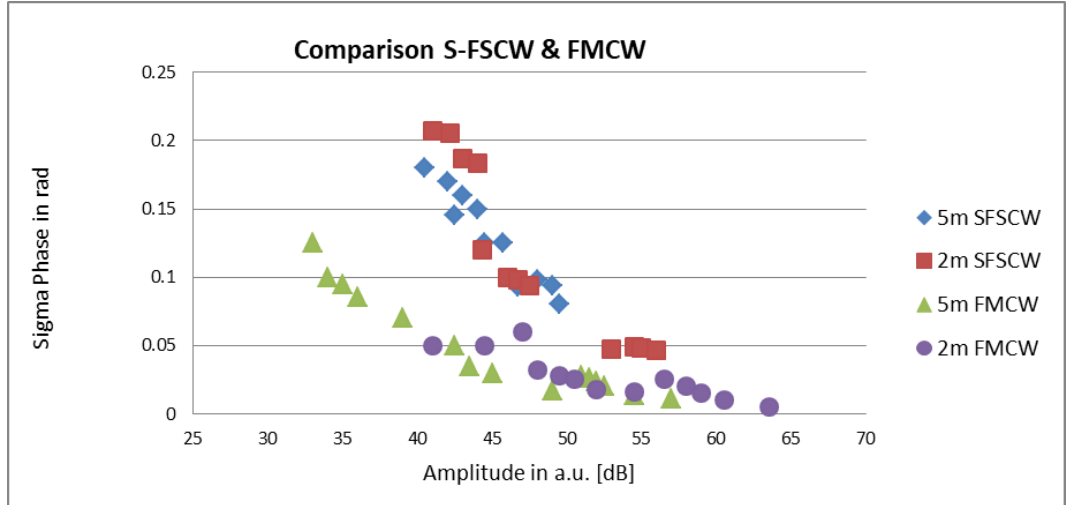
Figure 9. Comparison of the phase resolution of the S-FSCW and FMCW reader as a function of signal strength.